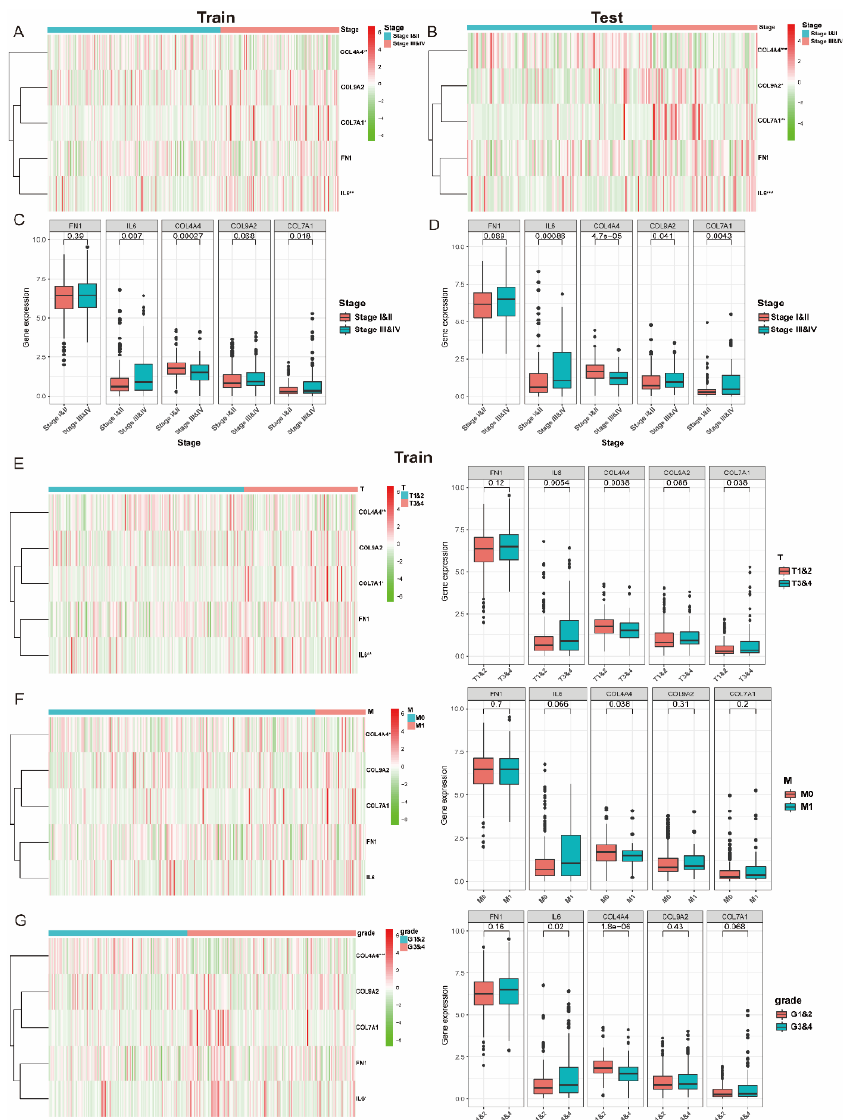
Figure 4. Collagen-related gene expression is correlated with clinicopathological features of ccRCC. ( A , B ) The heatmap showing five collagen-related gene expression profiles in different clinical stages from train and test cohorts; ( C , D ) The expression levels of five collagen-related genes in ccRCC with different clinical stages; ( E – G ) The heatmap and expression levels of five collagen-related genes in different T stage, M stage, and WHO grades from train and test cohorts; * p < 0.05, ** p < 0.01 and *** p < 0.001.